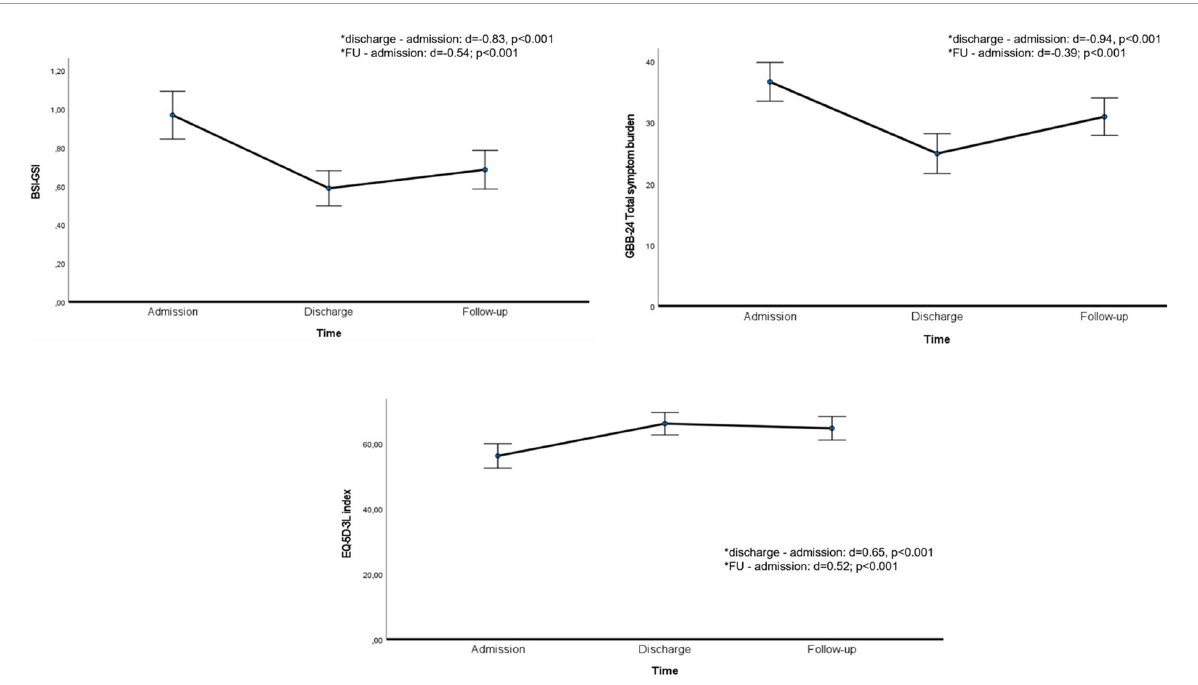
FIGURE2 Time course of BSI-GSI, GBB-24, and EQ-5D variables. BSI, Brief Symptom Inventory; CI, confidence interval; EQ, European Quality of Life Questionnaire; FU, follow-up; GBB, Giessen Subjective Complaints List; GSI, Global Severity Index. Asterisks (*) indicate significant differences between adjacent time points. Error bars indicate 95% CIs.